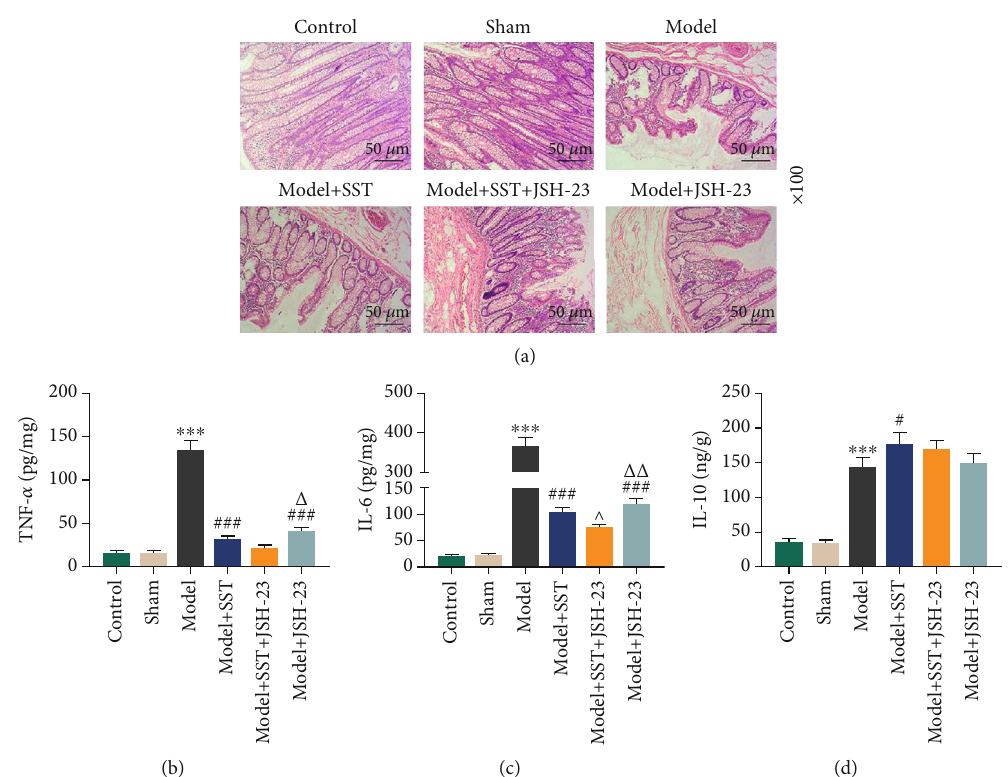
Figure 3: JSH-23 enhanced the protective e ff ect of SST on sepsis-induced intestinal barrier dysfunction. (a) Intestinal tissue from the control, sham, model, model+SST group, model+SST+JSH-23 group, and model+JSH-23 group was detected using hematoxylin and eosin (HE) staining. Sections presented ten mice in each group. Magni fi cation: 100x. Scale bar: 200 μ m. (b – d) Detection of in fl ammatory factors, including TNF- α , IL-6, and IL-10, in the ileum using ELISA. Data were shown as the mean ± SD from 3 independent experiments. ∗∗∗ P < 0 : 001 , vs. sham; # P < 0 : 05 ; ### P < 0 : 001 , vs. model. ^ P < 0.05, vs. model+SST. △ P < 0.05, △△ P < 0 : 01 , vs. model+SST+JSH-23. SST: